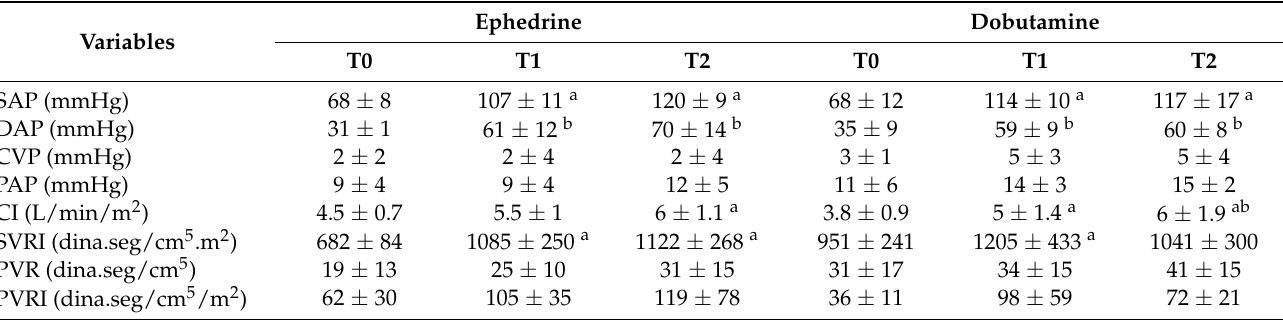
SAP: systolic arterial pressure, DAP: diastolic arterial pressure, CVP: central venous pressure, PAP: pulmonary artery pressure, CI: cardiac index, SVRI: systemic vascular resistance index, PVR: pulmonary vascular resistance, and PVRI: pulmonary vascular resistance index. Superscript letters indicate a significant difference ( p < 0.05) from the basal moment ( a ), from goal moment ( b ).